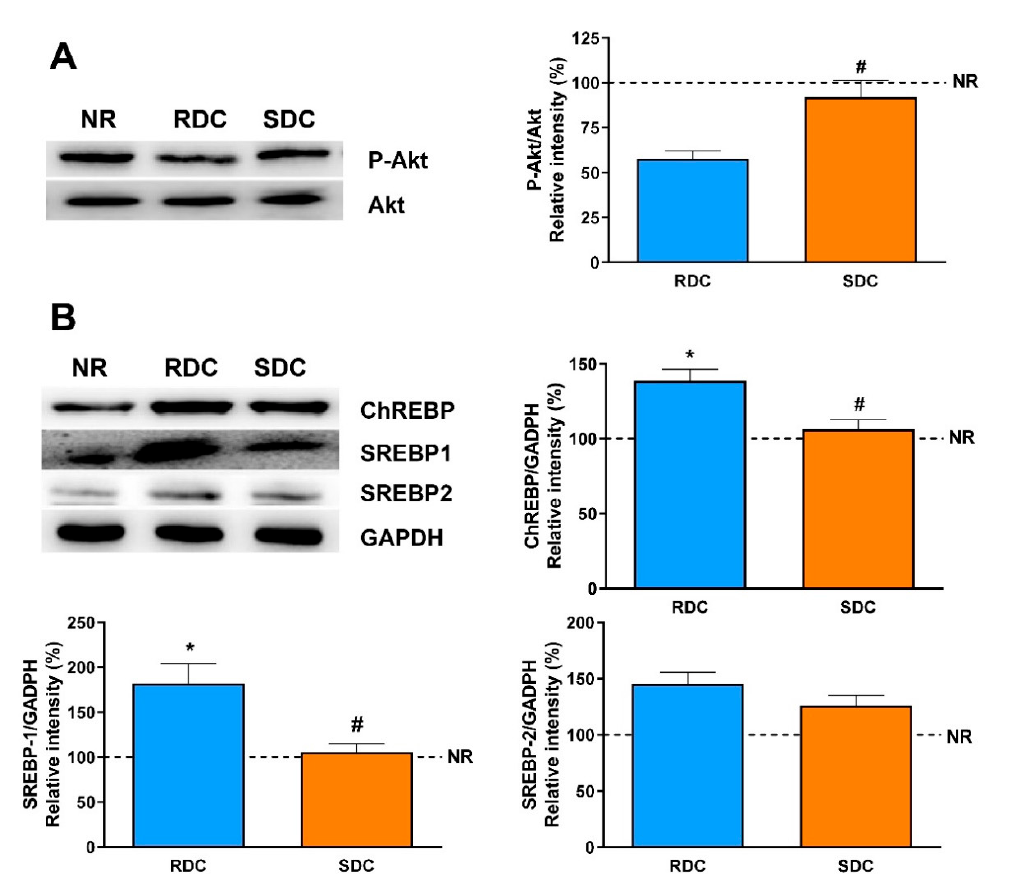
Figure 10. Signaling pathways in the liver of the di ff erent experimental groups. ( A ) Protein Kinase B / Ak strain transforming (PKB / Akt) phosphorylative status and ( B ) expression of carbohydrate response element binding protein (ChREBP), steroid response element binding proteins (SREBP1 and SREBP2). NR group, not restricted; RDC group, refeeding with rapid digestible CHO diet; SDC group, refeeding with slow digestible CHO diet. * Significant difference with NR group, p < 0.05. # Significant difference with RDC group, p < 0.05.